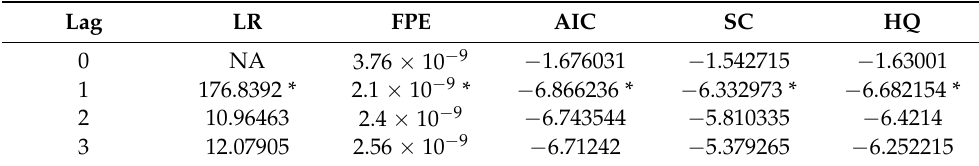
Table 3. Selection of the lag order of the model.